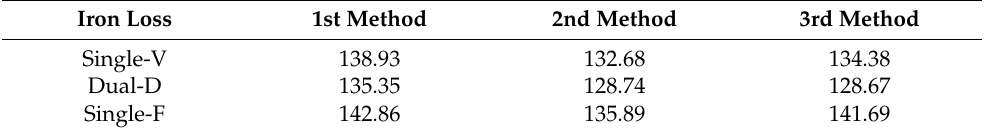
Figure 8. Comparison of ( a ) iron losses and ( b ) hysteresis losses of three different calculation methods at 6540 rpm, 24 A phase current. Table 1. Comparison of iron losses of three different calculation methods at 6540 rpm, 24 A phase current.